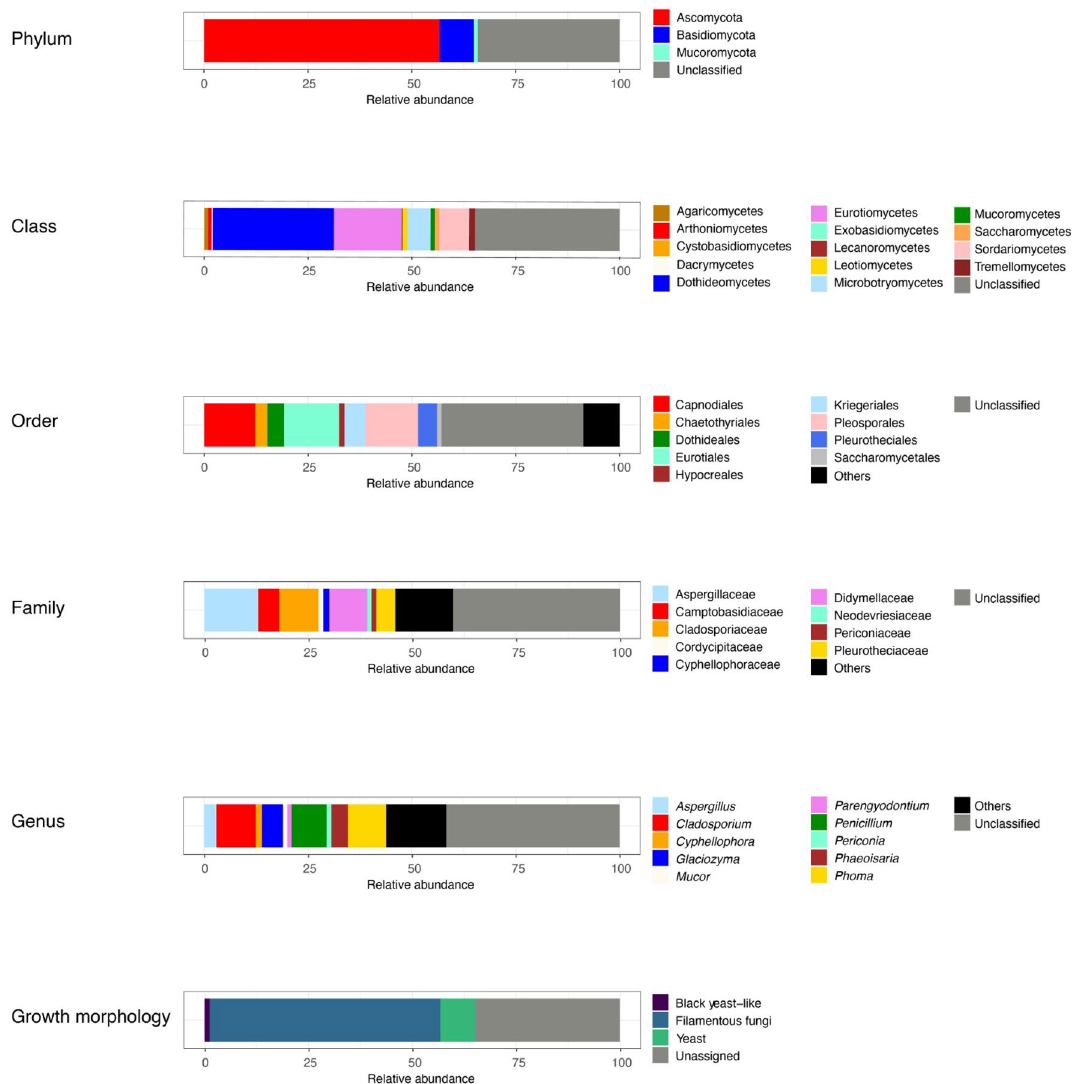
Figure 4. Fungal community composition of BC brine at different classification levels. Only relative abundances greater than 1% are